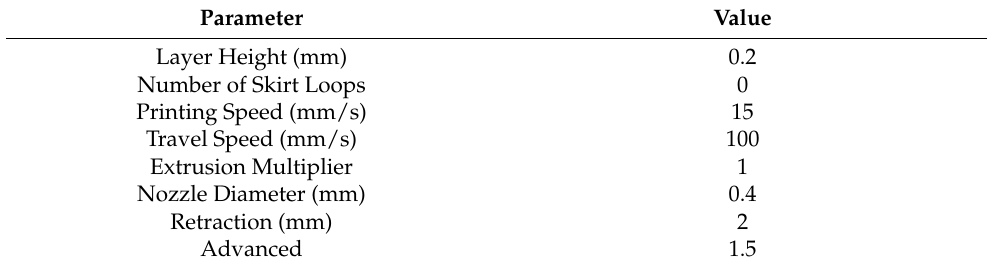
Table 2. Tuning parameters of a 3D printing process